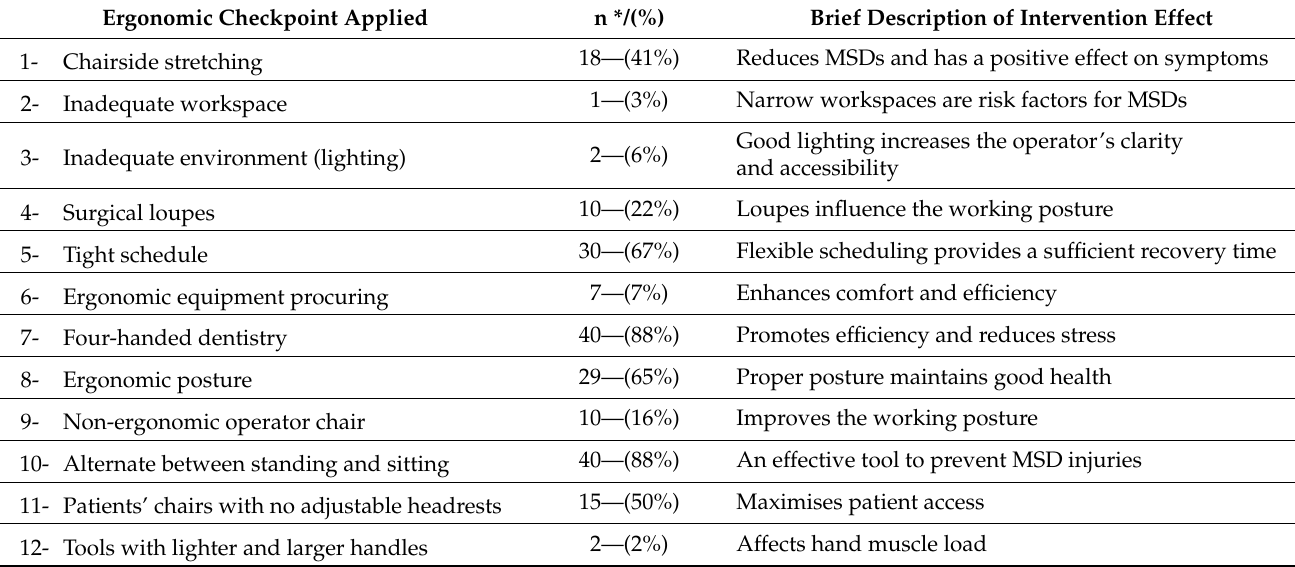
Table 3. Dental staff ergonomic checklist results.